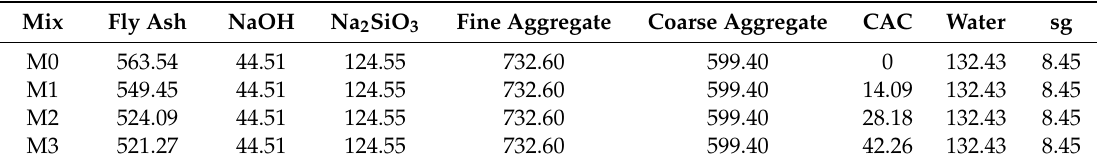
Table 2. Details of mix proportion (kg/m 3 ).